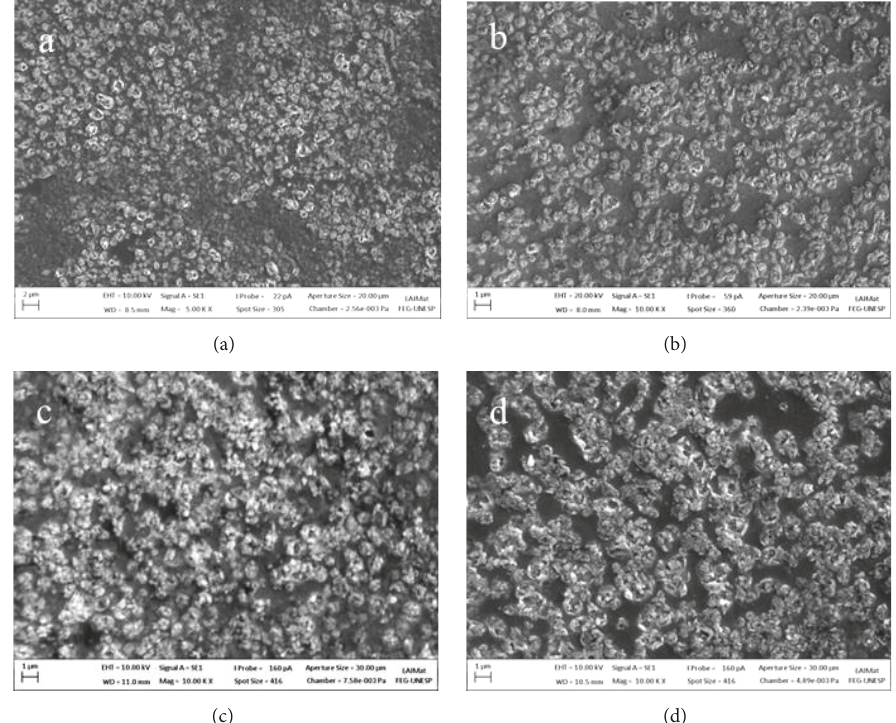
Figure 4: SEM images of nonelectropolished titanium surfaces after anodisation at different pulsed current frequencies: (a) 100 Hz; (b) 10Hz; (c) 1Hz; and (d) 0.33 Hz.